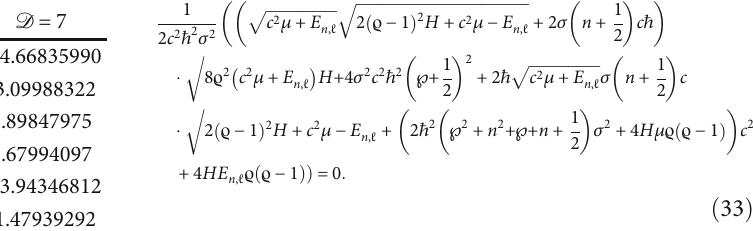
Table 1: The energy spectra E = 1 , Η = 20 , T = 10 , and ϱ = 0 : 1 for D = 3 , 5, and 7.